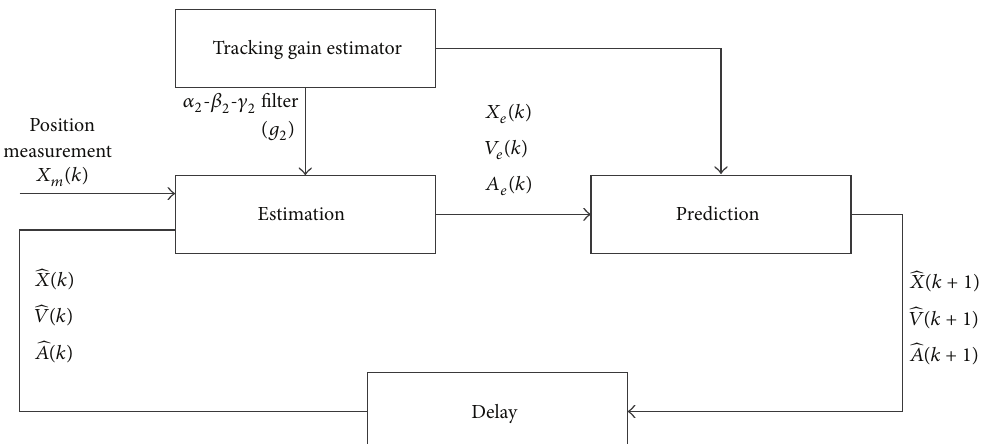
Figure 3: Adaptive 𝛼 - 𝛽 - 𝛾 filter for target tracking in three-dimensional